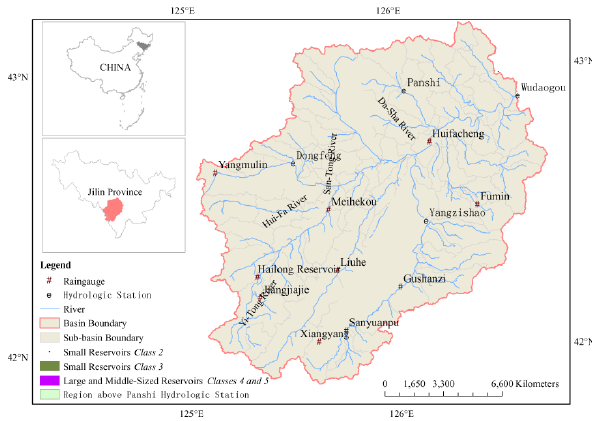
Fig. 3. The Fengman Reservoir